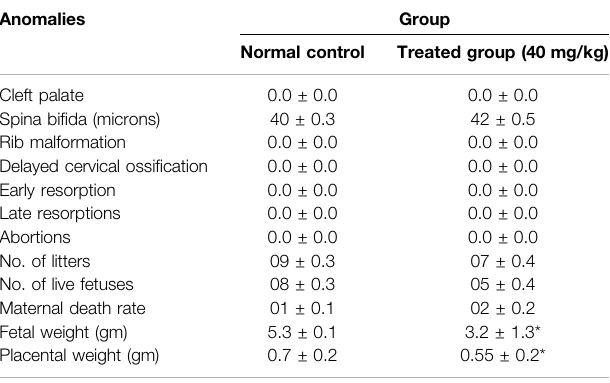
MDA levels in tissues: Abs 532 × 100 × V t Conc . of MDA (cid:1)